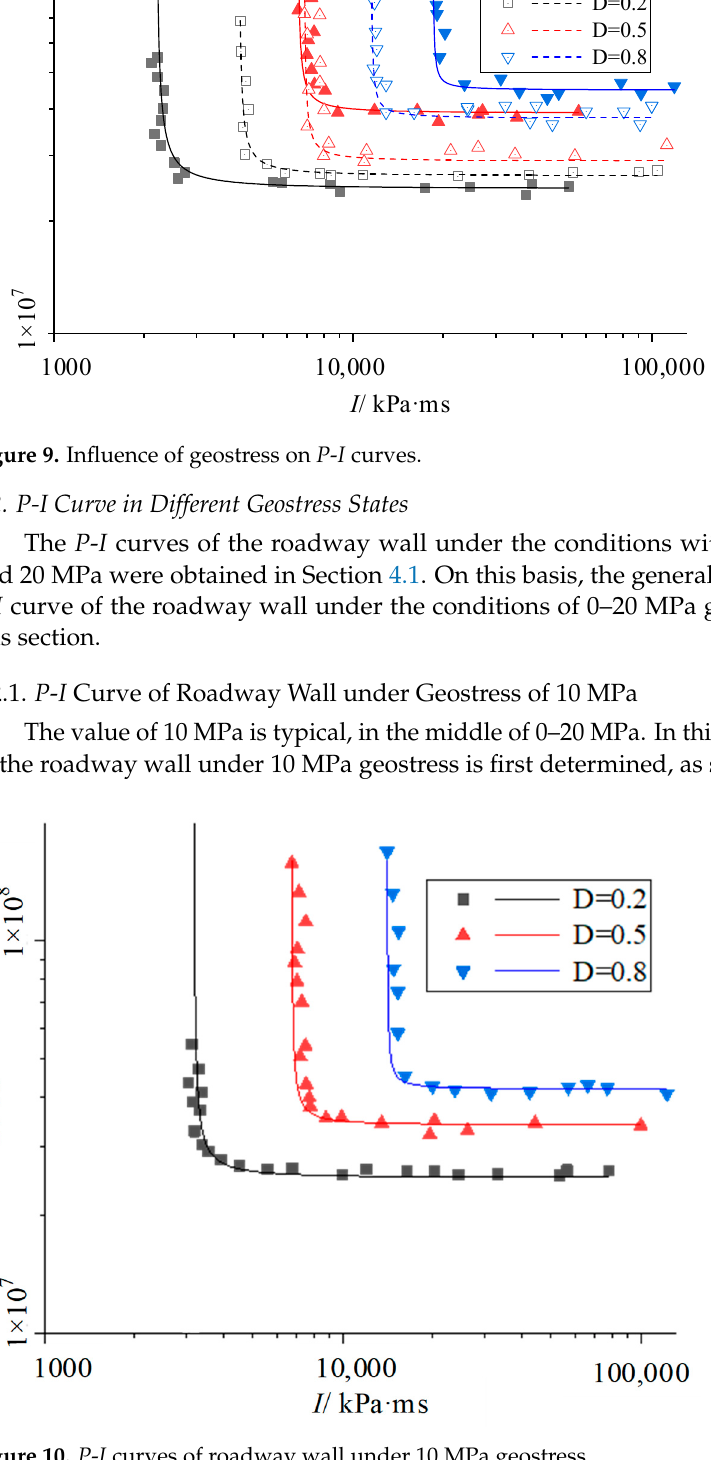
Figure 10. P - I curves of roadway wall under 10 MPa Figure 10. P-I curves of roadway wall under 10 MPa geostress.